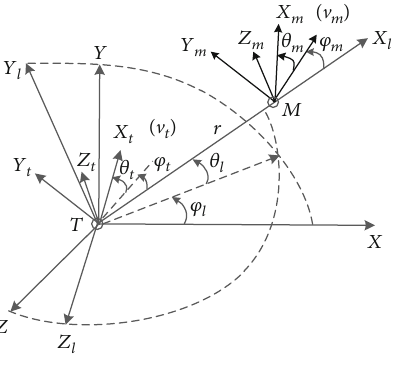
Figure 1: Head-pursuit interception schematic. Figure 2: Three-dimensional engagement